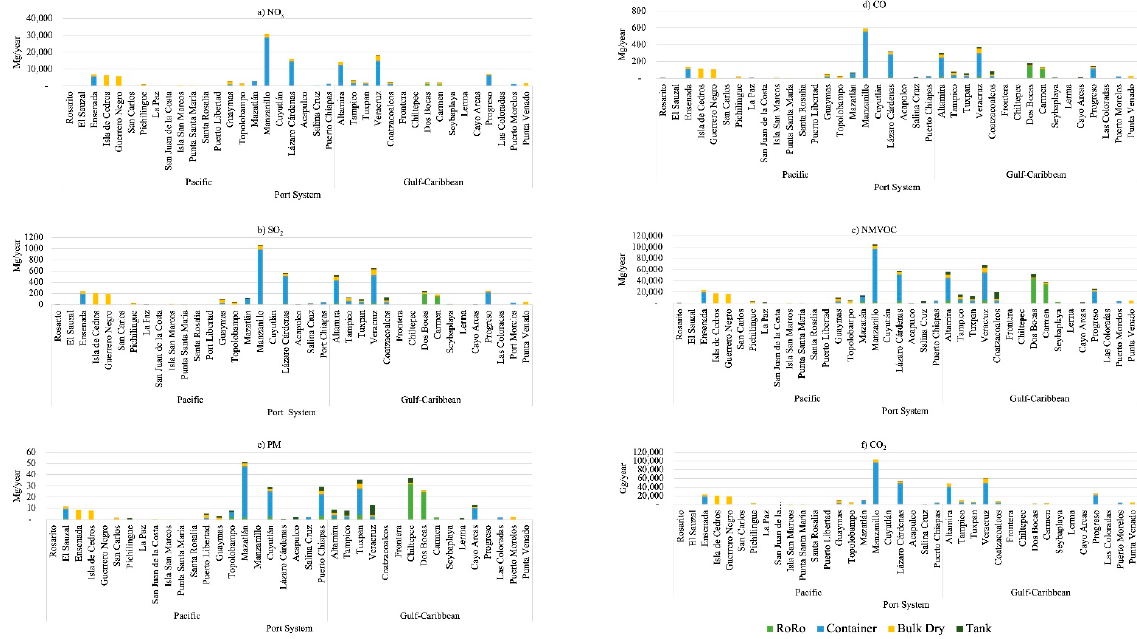
Figure 7. Atmospheric emission for ( a ) NO x , ( b ) SO 2 , ( c ) PM, ( d ) CO, ( e ) NMVOC, and ( f ) CO 2 for each port and type of vessel.